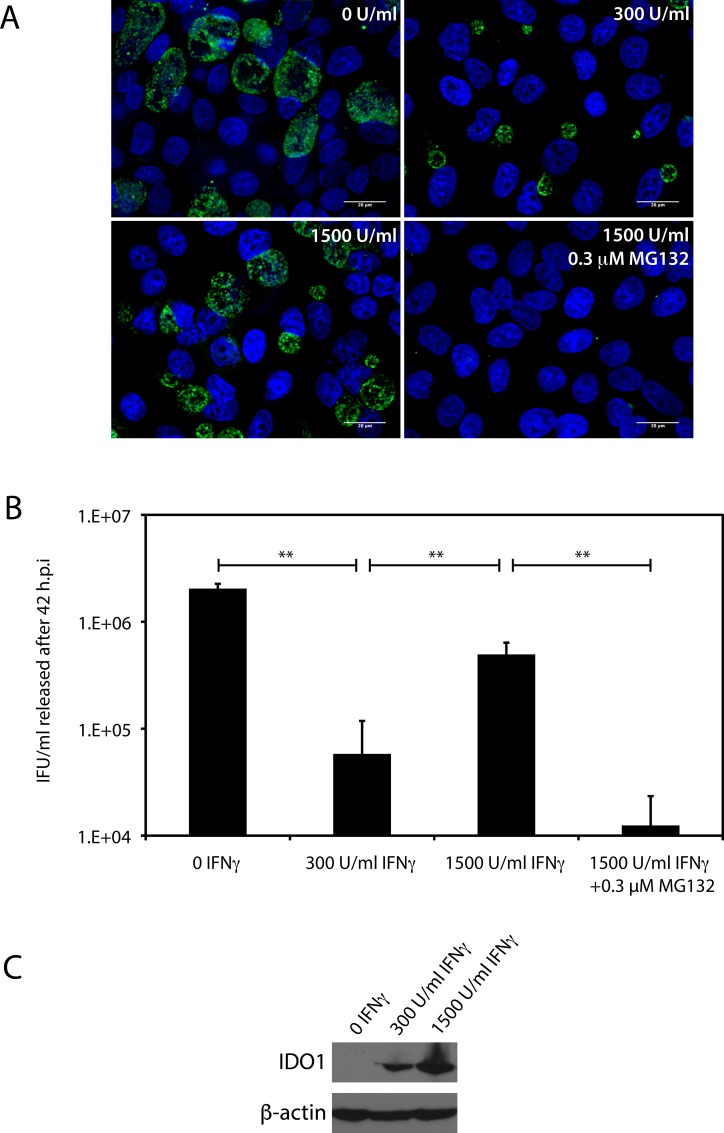
High levels of IFNγ partially restores C. trachomatis development in HeLa cells.After infection with C. trachomatis, HeLa cells were grown in DMEM containing 4 mg/L of tryptophan, and treated with 0, 300, 1500 U/mL of IFNγ, or I500 U/mL IFNγ + 0.3 μM MG132 for 42 hours, following which inclusion formation and IFU recovery were evaluated. A) Immunofluorescence using a FITC-conjugated anti-chlamydial LPS antibody was used to evaluate inclusion formation under the four conditions described above. Cells were counterstained with Hoechst dye. B) IFU/mL recovered at 42 h.p.i. from cells grown under the four conditions described above. IFU recovery was quantified by infection of HeLa cells. As reported previously [19], the addition of 300 U/mL IFNγ resulted in a statistically significant 2-log decrease in IFU recovery. Addition of 1500 U/mL IFNγ resulted in a statistically significant ~1-log increase in the IFU recovered relative to the addition of 300 U/mL IFNγ. IFU recovery was addition of 1500 U/mL IFNγ was significantly reduced by the concurrent administration of 0.3 μM MG132. The data represent three independent experiments (** indicates P < 0.001 by the Wilcoxon rank sum test).